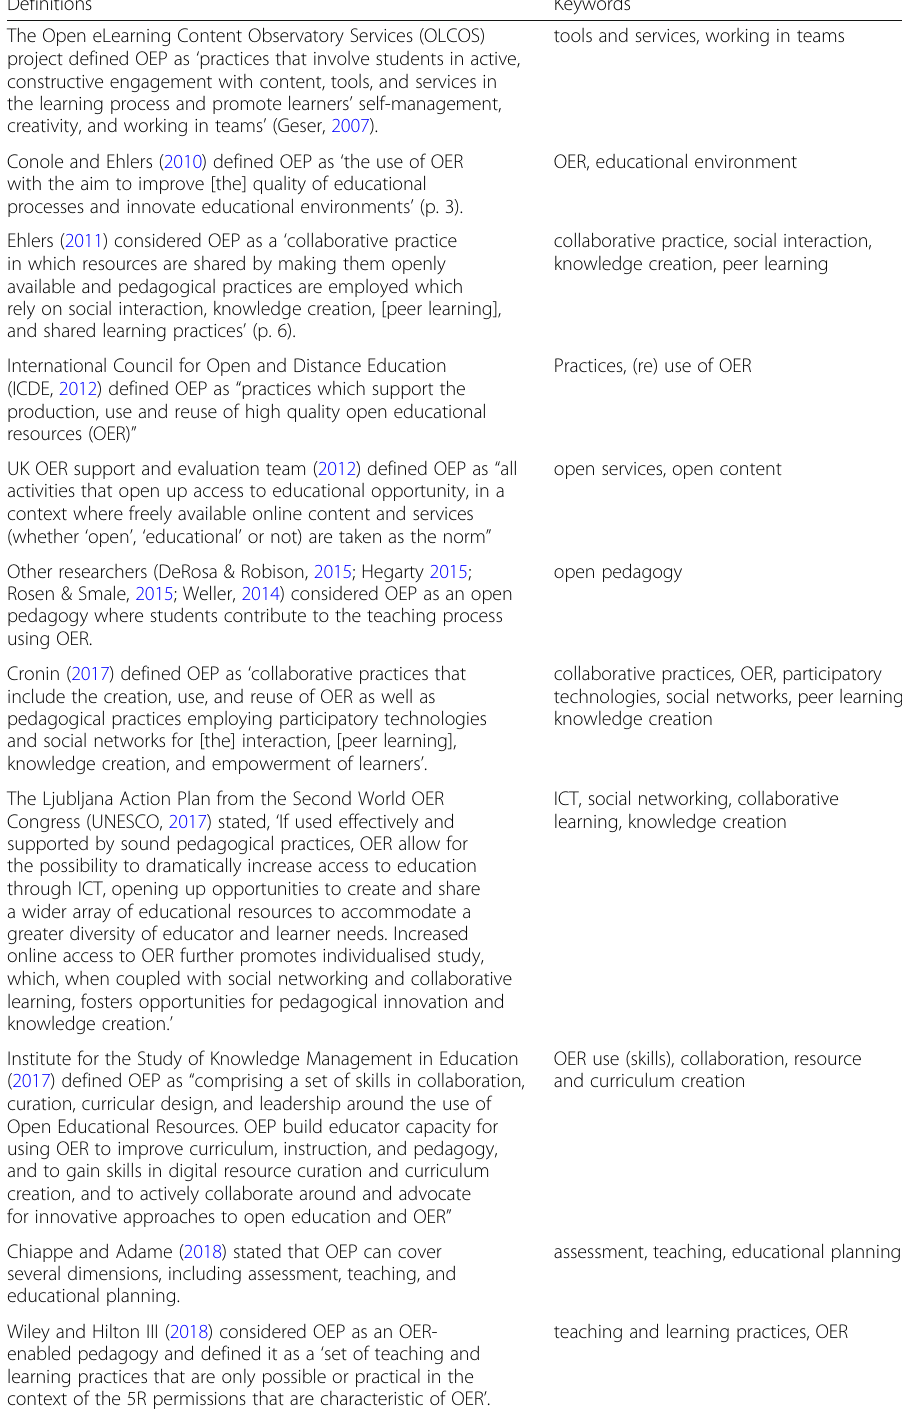
Table 1 Review of OEP definitions in the literature and the extracted keywords